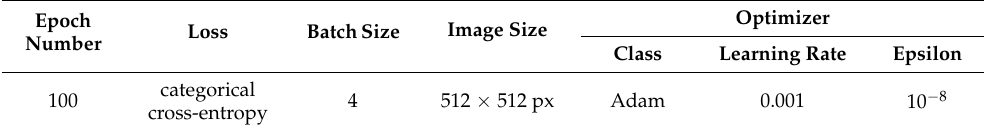
Table 3. Training parameters for